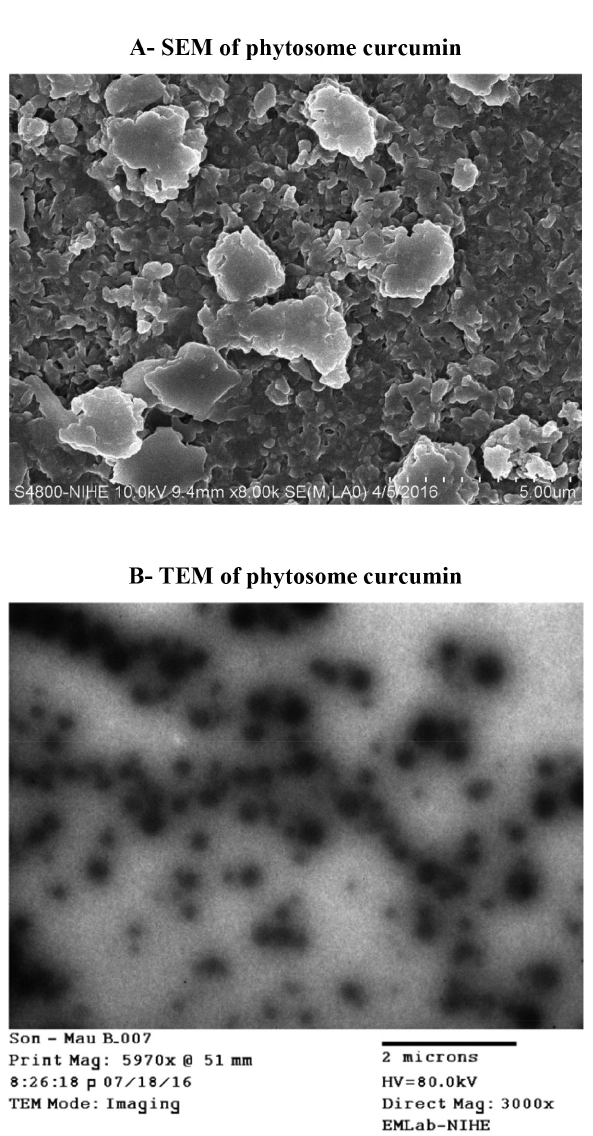
FIGURE 2 - Phytosome curcumin was taken by SEM (A) and TEM (B) of phytosome curcumin with curcumin: phosphatidylcholine ratio is